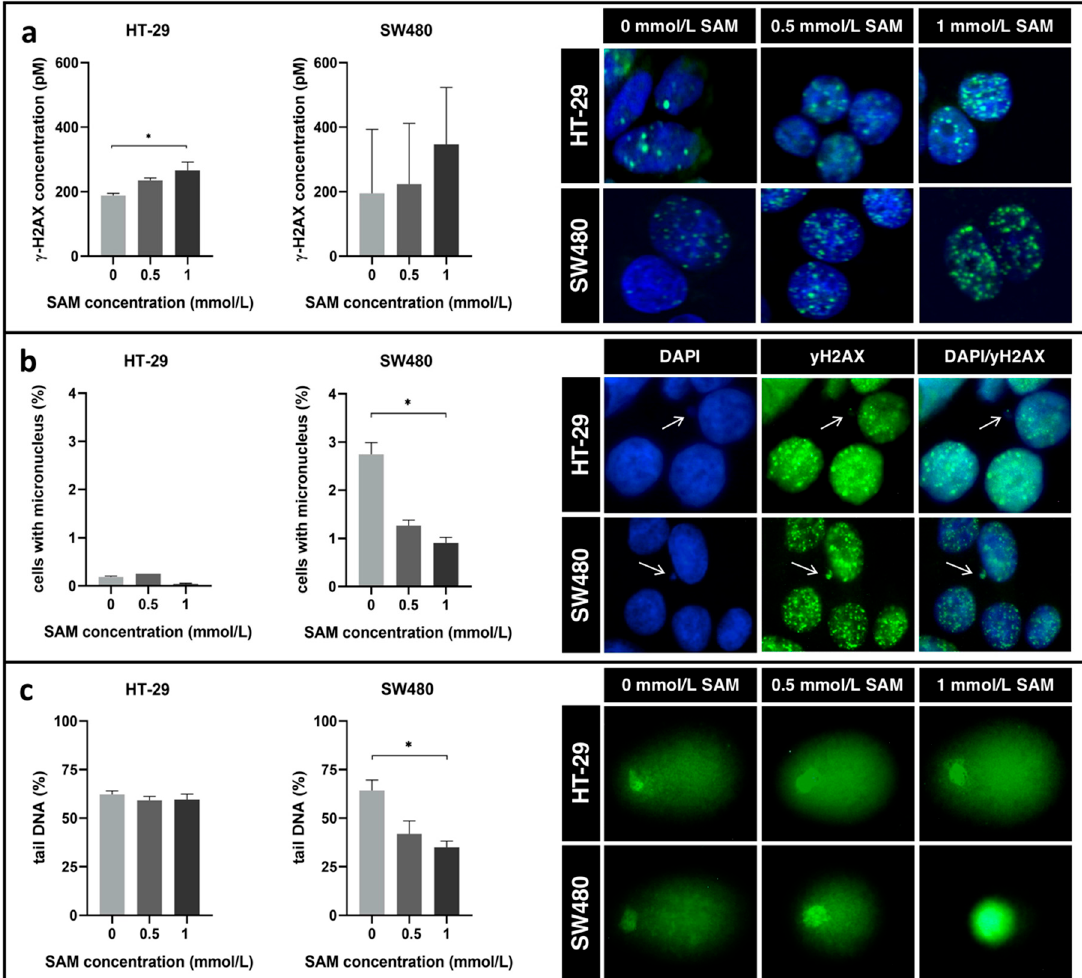
Figure 4. ( a ) Left: Concentration of γ -H2AX was determined with ELISA. Right: Representative immunofluorescence staining images of γ -H2AX intensity following SAM treatment were captured. ( b ) Left: Micronucleus scoring was performed on the slides stained with DAPI and anti- γ -H2AX (* p ≤ 0.05). Right: Arrows indicate representative micronuclei with γ -H2AX positivity. ( c ) Left: Percentage of DNA in the tail was referred as comet tail DNA % (* p ≤ 0.05). Right: Characteristic comets are visualized following SAM treatment.